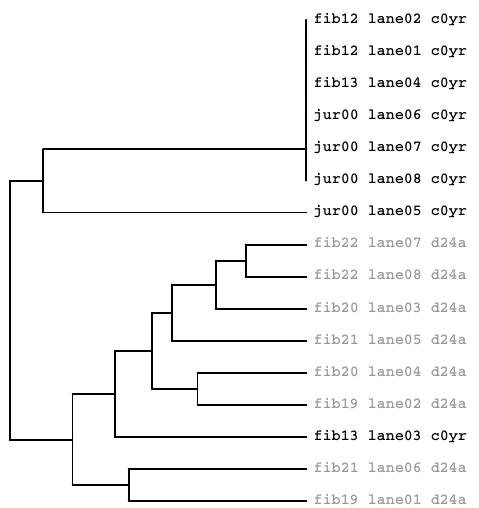
Figure 6. Clustering of Fastq files containing filtered reads: All reads containing Phred scores < 30 had been discarded before HcKmer analysis. On top level clade, the Jurkat cell samples still exclusively cluster together with samples from the same